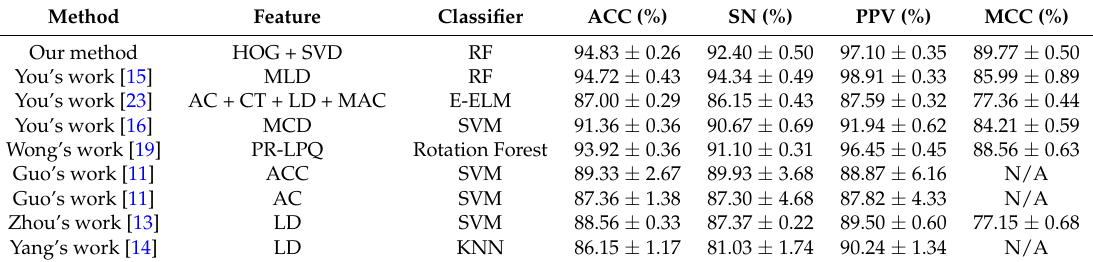
Table 3. Comparison of the prediction performance between our proposed method and other state-of-the-art works on the S . cerevisiae dataset. N/A means not